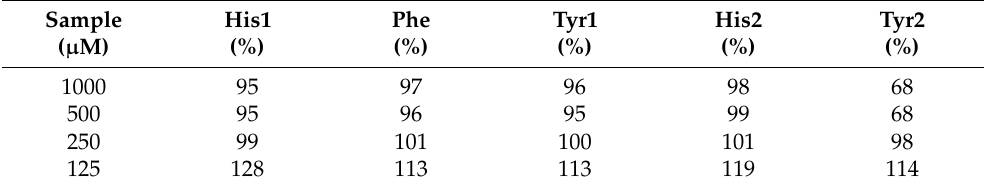
Table 3. Recoveries (%) of the amino acid series using TPA to quantify each signal.